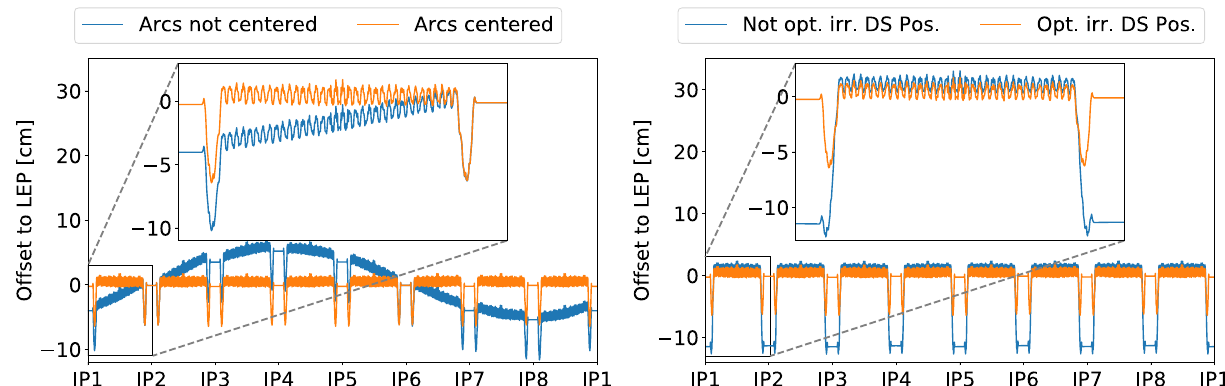
FIG. 11. Upper: Impact of shifting the arc position by 1.2 m counterclockwise for an 18-cell HE-LHC design on the geometry offset with respect to LEP. Lower: Impact of shifting DS position with respect to the interaction point. Shifting all DSs 3 m towards the IRs reduces the geometry offset in the interaction region by about 11 cm with respect to LEP for an 18-cells-per-arc HE-LHC